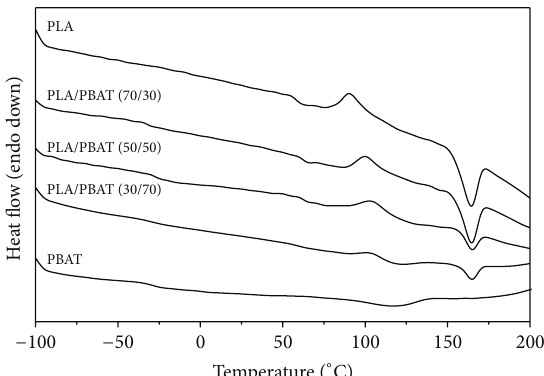
1 𝑇 𝑔 -PBAT : The temperature of glass transition region of PBAT. 2 𝑇 𝑔 -PLA : The temperature of glass transition region of PLA. 3 Δ𝑇